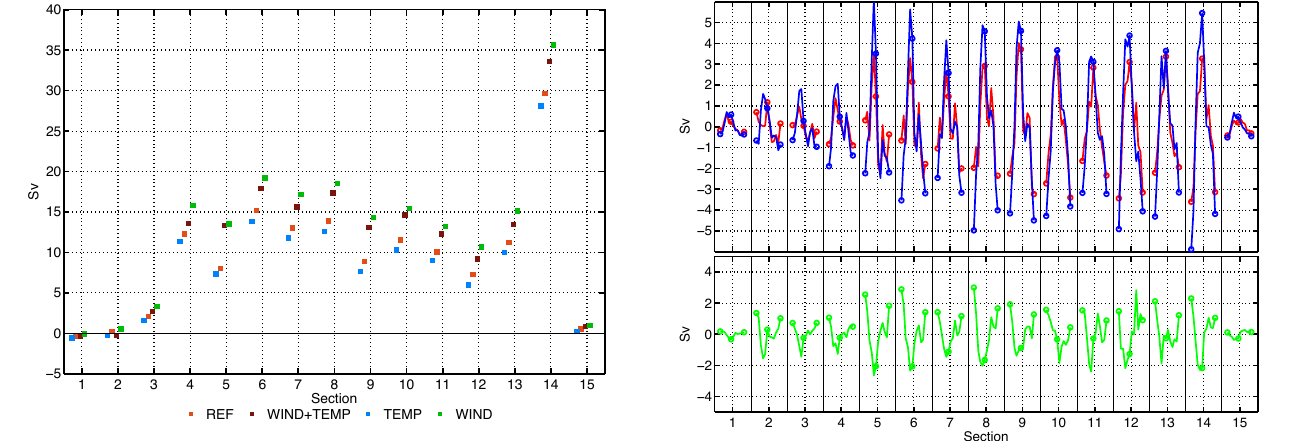
Fig. 11. Annual mean transport associated with the ASC in Sv across each section (horizontal axis) shown in Fig. 1 for TEMP (blue), REF (orange), WIND + TEMP (brown) and WIND (green).